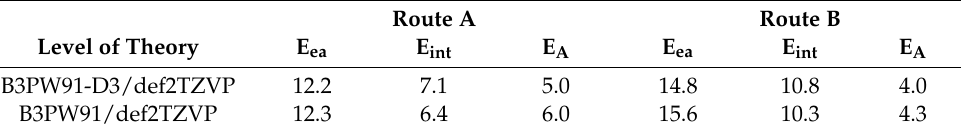
Figure 3. (Color online) Figure ( a ) shows the energy profile of a chemical reaction (route A) with two symmetric transition states (TS1, TS2) and one intermediate (Int) for the interconversion between the lowest energy P and M enantiomers (see video of intrinsic reaction path in Supplementary materials). The enantiomerization energy (E ea ) was 12.14 kcal/mol at room temperature. In contrast, the intermediate structure lay at 7.13 kcal/mol (E Int ) above the putative global minimum P and M structures; thus, the activation energy in the interconversion from the intermediate (Int) to the M or P structure was 5.0 kcal/mol, at room temperature. Figure ( b ) displays the enantiomerization energy (E ea ) depicted by a blue-solid line. The relative energy of the intermediate structure (E Int ) with respect to the putative global minimum is depicted by a red solid line. The activation energy barrier (EA) between the intermediate structure and the P or M structure is indicated by the violet arrow and is the difference between E ea and E Int for temperatures ranging from 100 to 1300 K. The green and copper-colored spheres represent the copper atoms. Green represents a Cu atom that is moving; the chirality is due to this atom. Table 2. Values of enantiomerization energy (E ea ), relative energy of the intermediate (E Int ), and activation energy (E A ) for two reaction mechanisms, A and B, taking or not considering D3 Grimme’s dispersion. The inclusion of dispersion lowers the energy barriers, i.e., in B the E A decreased by 7% (from 4.3 to 4.0 kcal/mol).